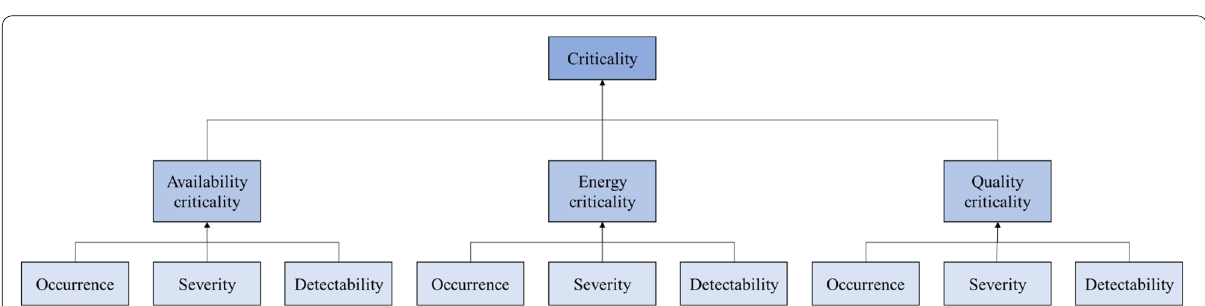
Figure 9 Functioning model of MOCA